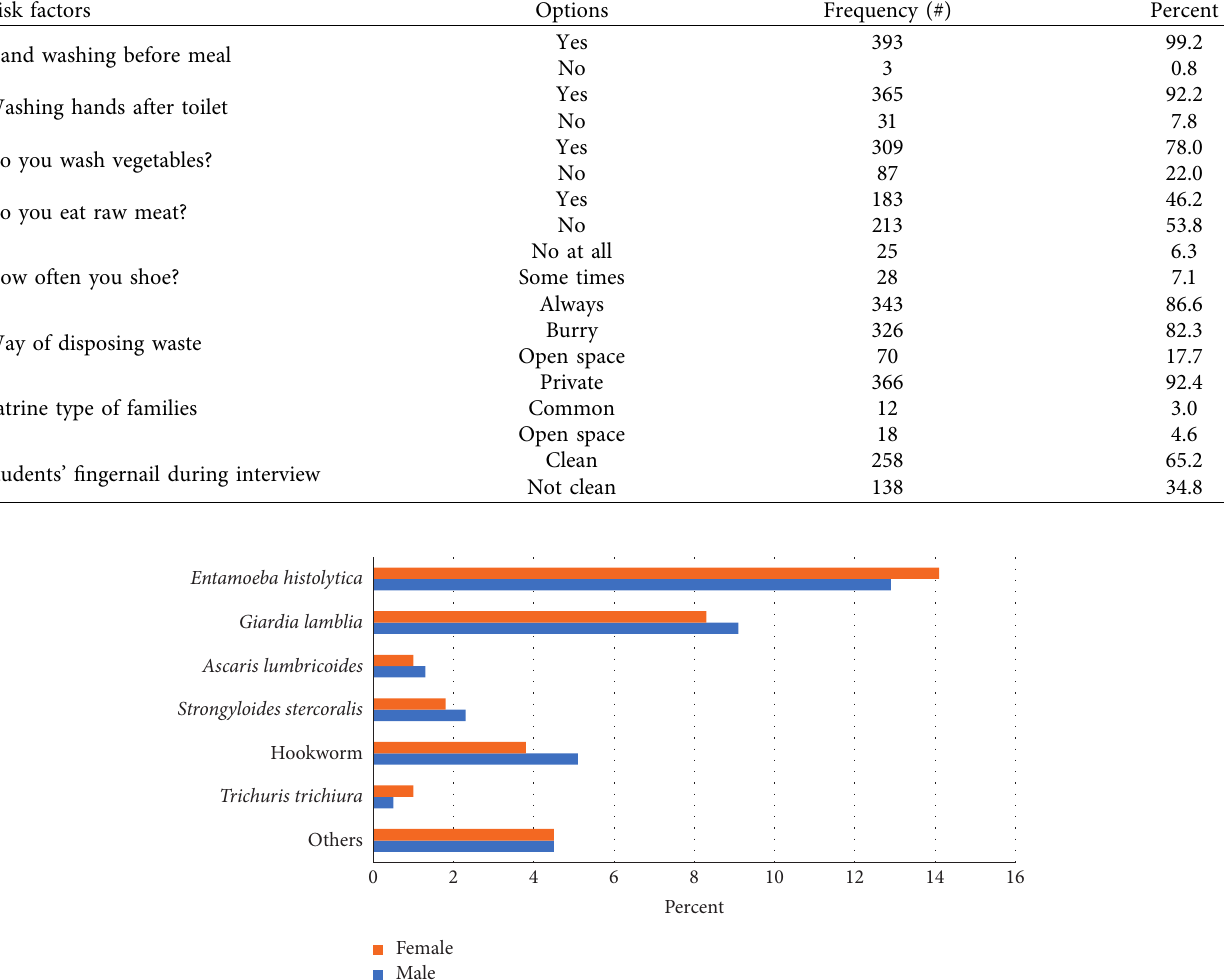
Figure 1: Prevalence of single intestinal parasites among school children in Jaragedo primary and secondary schools, northwest Ethiopia. Table 2: Prevalence of intestinal parasitic infections among school children in relation to explanatory variables.